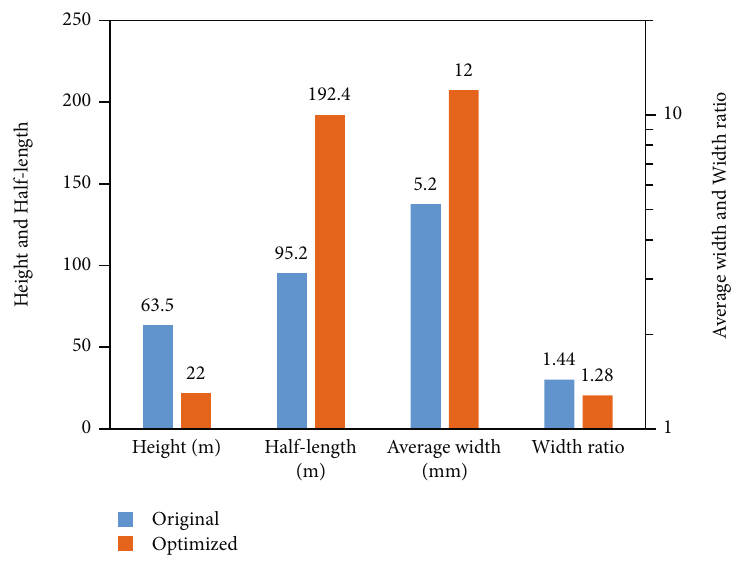
Figure 20: The comparison of original and optimized fracture parameters.